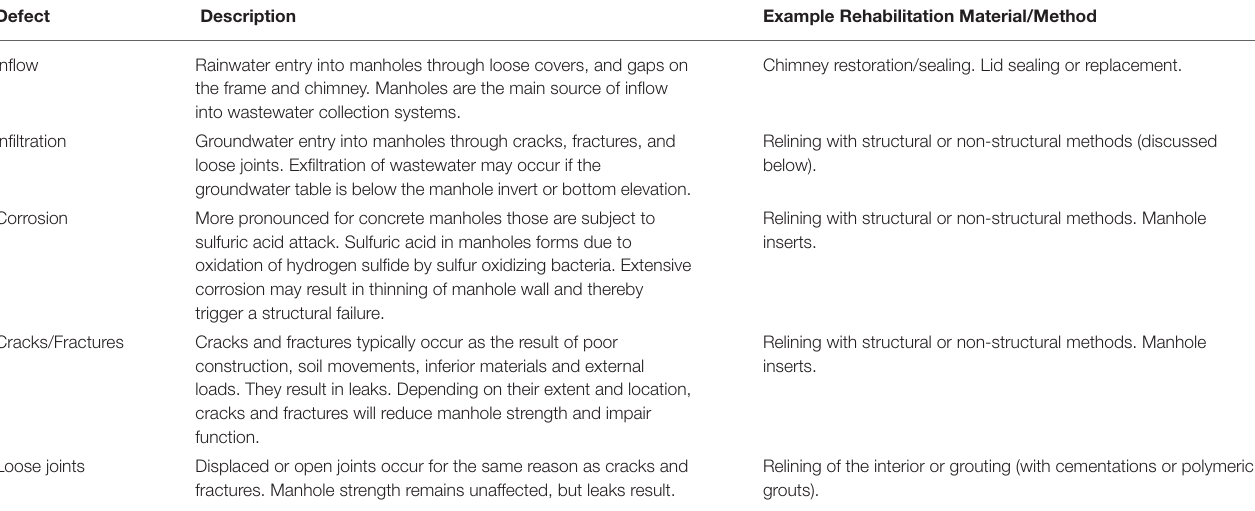
TABLE 1 | Common Manhole Problems (Entezarmahdi, 2015).